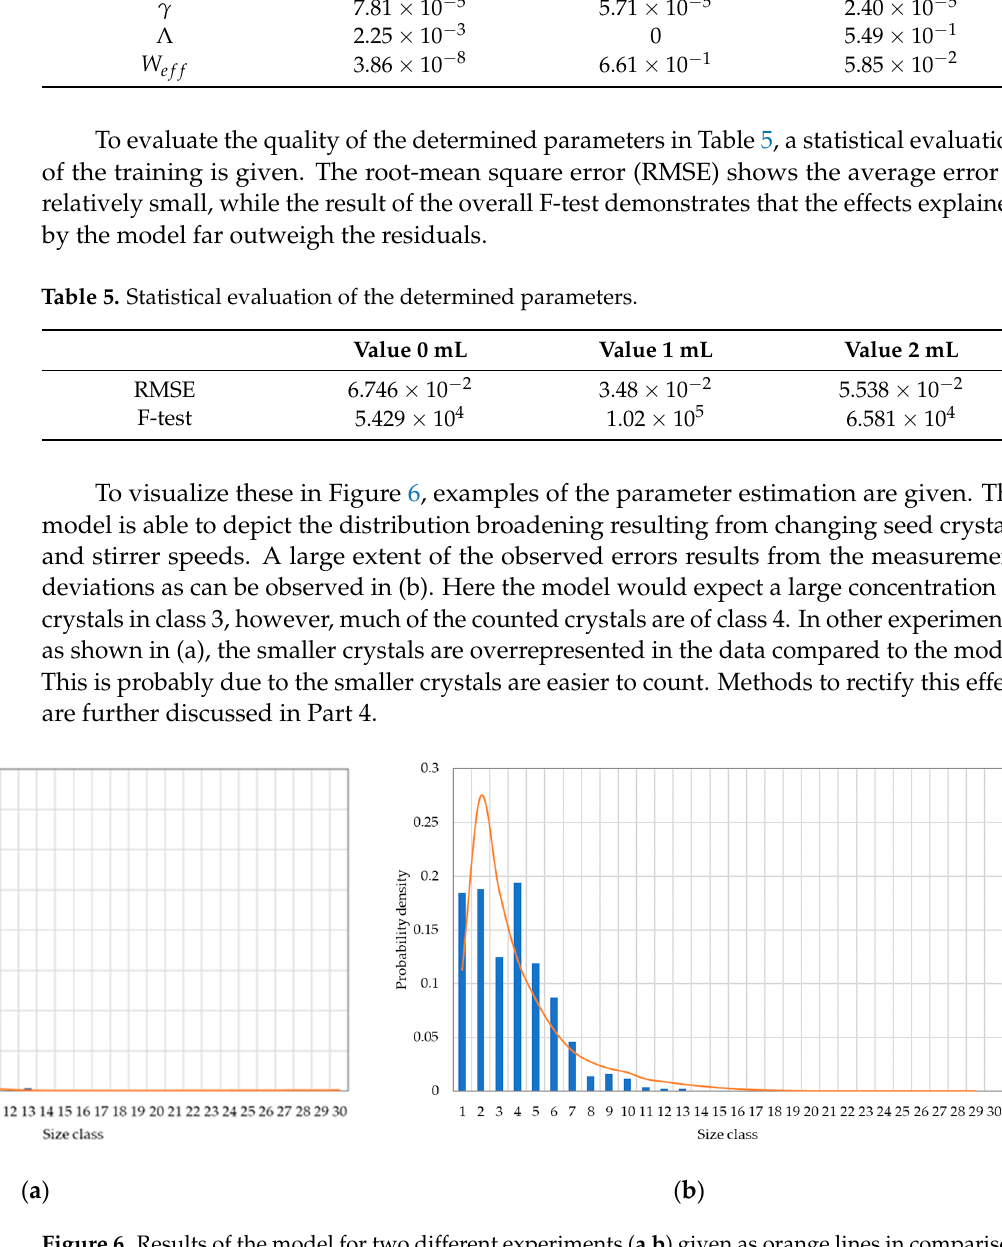
( b ) Figure 7. The concentration courses for two different experiments (a) and (b). Green crosses are measured data, the dark blue line is the sigmoid function fit described in the methods, the orange line is the result of the model. 4. Discussion Based on the reported data, it is clear that a physico ‐ chemical model holds a signifi ‐ cant advantage over a simple statistical evaluation. On the one side, the results of the